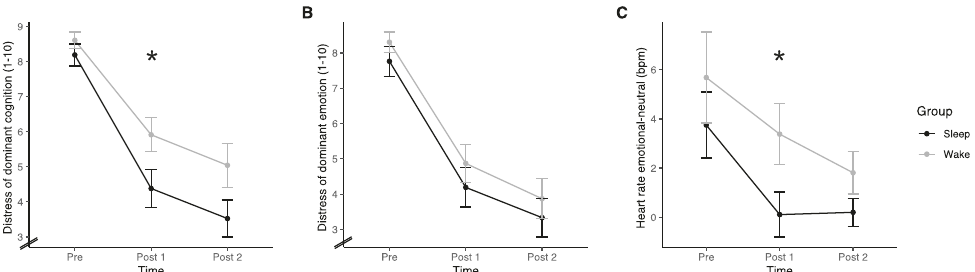
Fig. 3 Emotional response to the aversive memories. Distress of dominant cognition ( A ), distress of dominant emotion ( B ), HR response in bpm (emotional – neutral) ( C ) for the sleep (black lines) and wake group (grey lines) across the three timepoints (pre, post 1, post 2). Heart rate response was computed by subtracting mean HR during imagery of the neutral memory script from mean HR during imagery of the aversive memory script; the degree of induced distress ranged from 1 = not at all to 10 = extremely strong. * p <